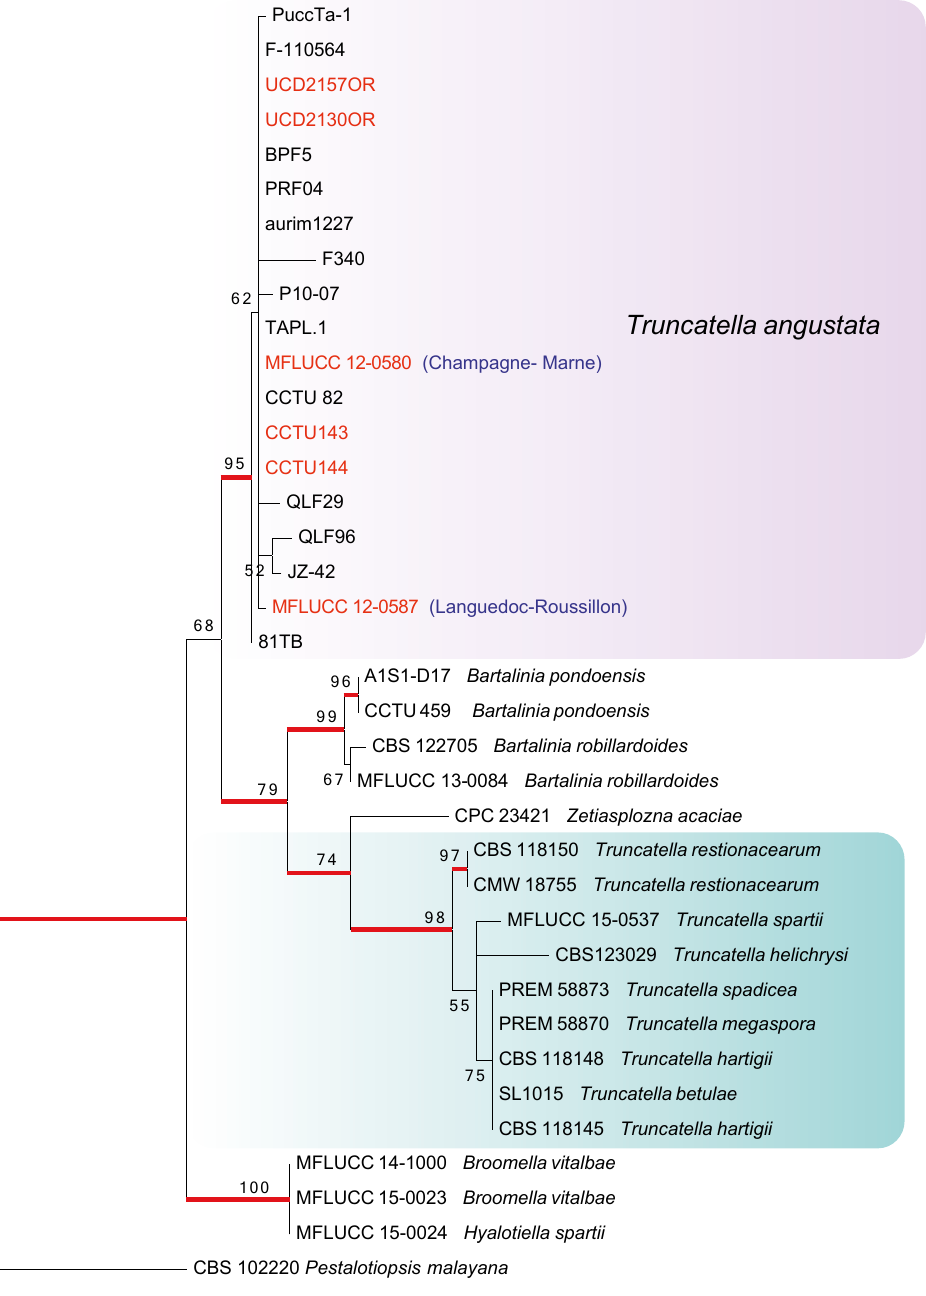
Figure 3. Consensus phylogram (50% majority rule) of 1,000 trees resulting from a RAxML analysis of the ITS sequence data of Truncatella and other genera in the family Bartalaniaceae . Red-thickened lines indicate Bayesian posterior probabilities (PP) above 90%, and RAxML bootstrap support values (MLB) above 50% are given at the nodes. The scale bar represents the expected number of changes per site. Strain accession numbers are followed by the species name (isolates derived from grapevine are printed in red). The tree is rooted to Pestalotiopsis malayana (CBS